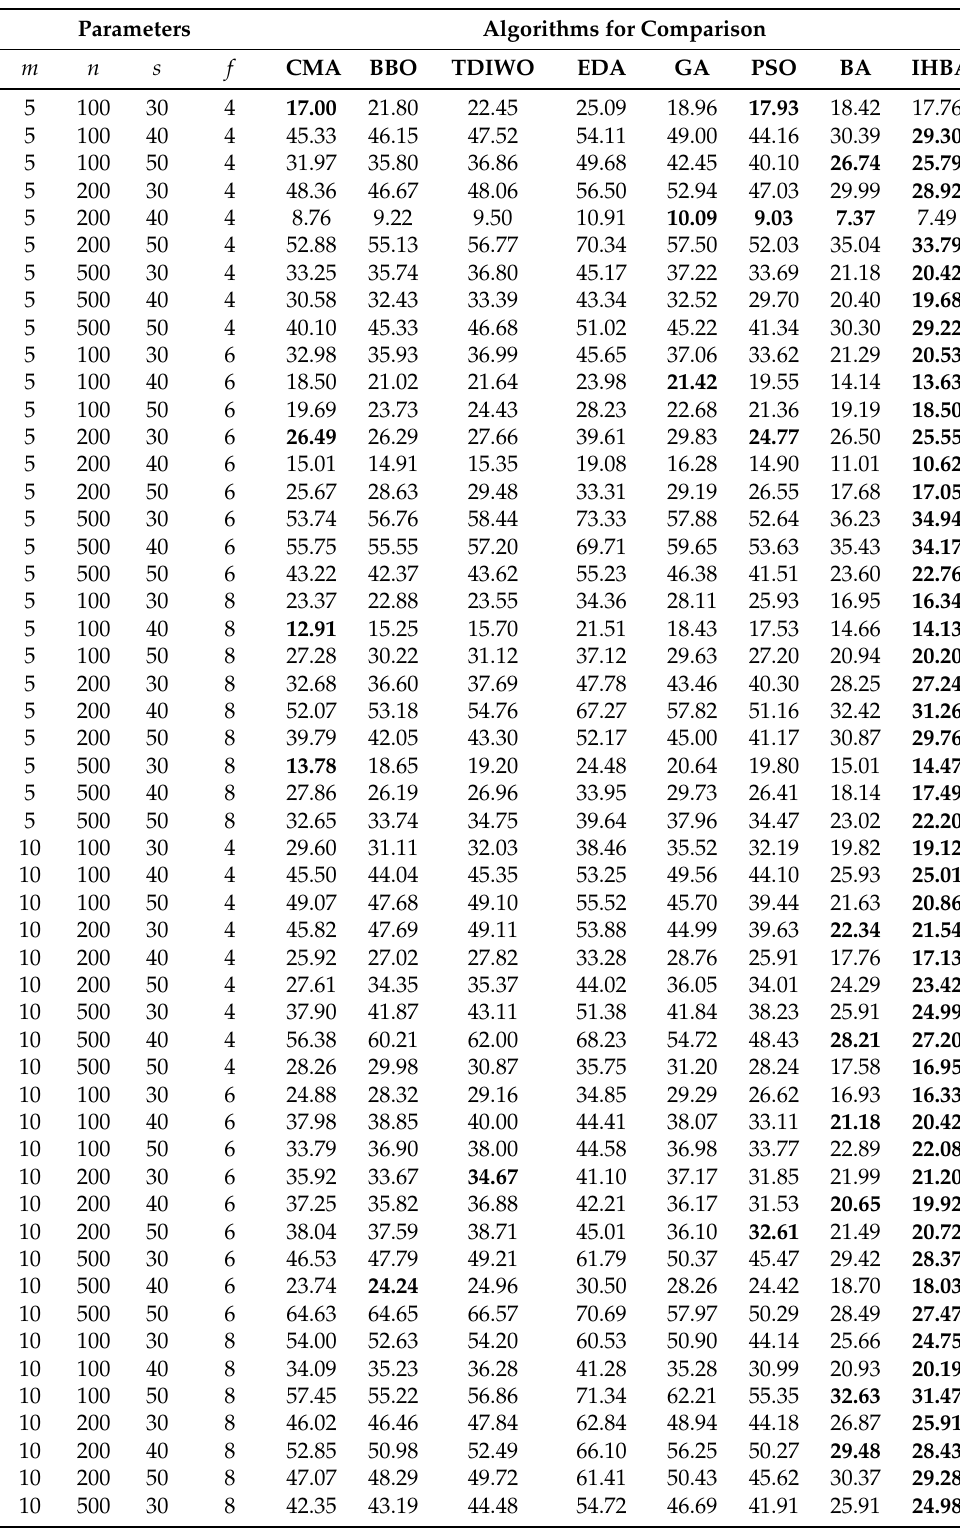
Table 7. The Average RPD Values at C = 40. It can be seen from the bold figures that the value of PRD of the proposed algorithm IHBA in this paper is smaller than that of other algorithms in the vast majority of combinatorial solutions, including the recognized TDIWO algorithm and the original bat